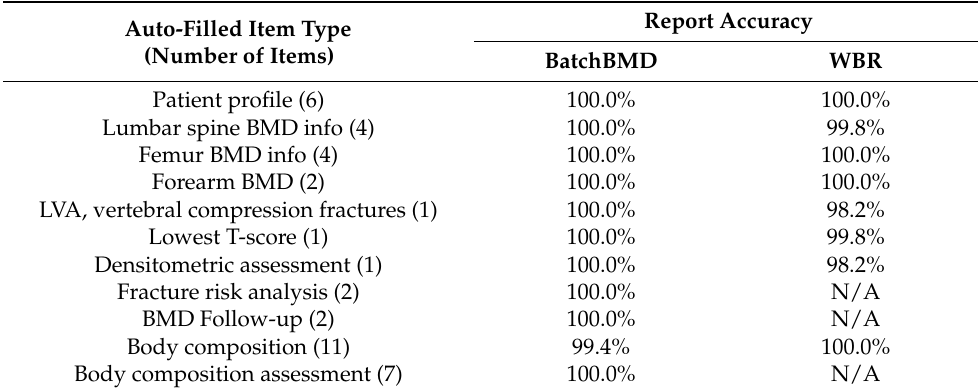
Table 1. Accuracy of auto-filled items during evaluation (500 scans) of BatchBMD, compared to a Web-based Reporting system.